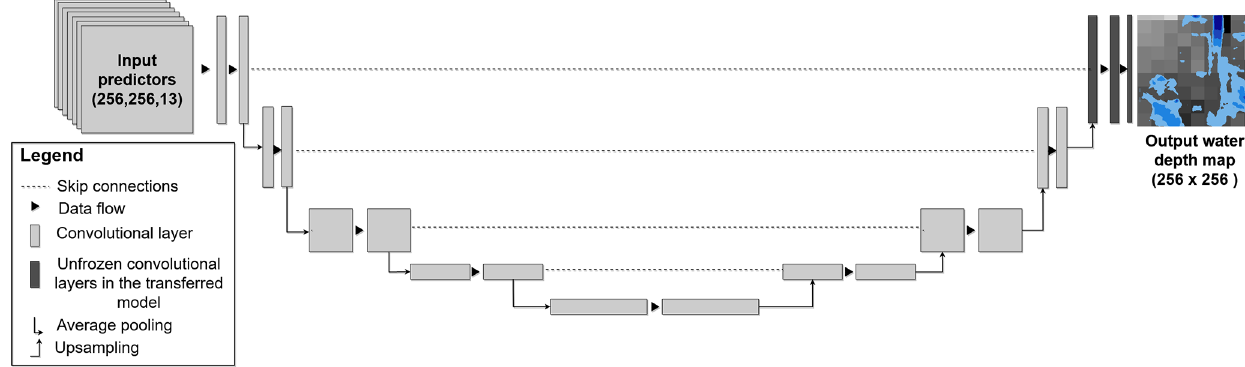
Figure 2. Schematic diagram of the applied U-Net architecture for a network of depth = 4 (four blocks of encoder and decoder). The transferred model obtained the weights from the pre-trained model except for the weights in the last decoder block (black color). Then, the new training data were used to train the remaining untrained weights.